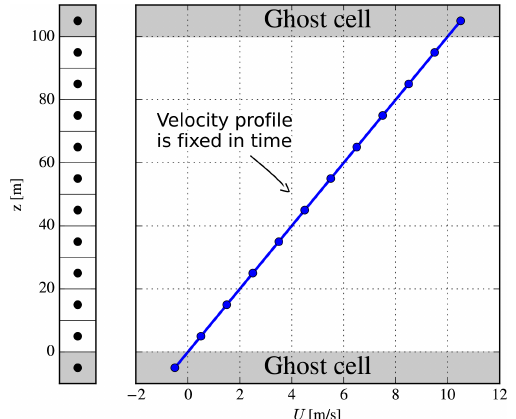
Figure 3. Mesh and the prescribed velocity profile in EllipSys1D for the homogeneous-shear-flow